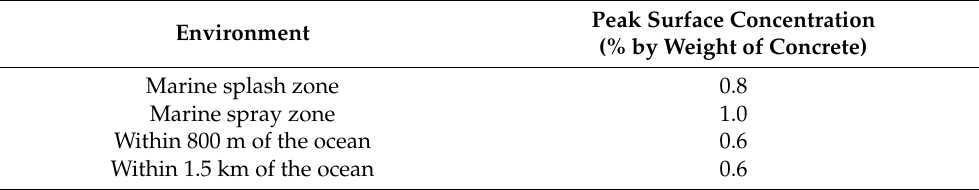
Table 1. Peak values for marine conditions (Data from Ehlen et al. [7]).